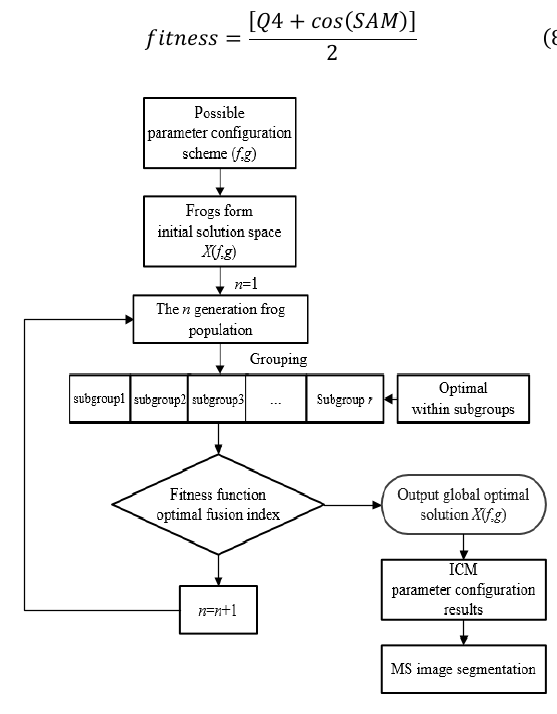
Figure 3. Process of ICM parameter